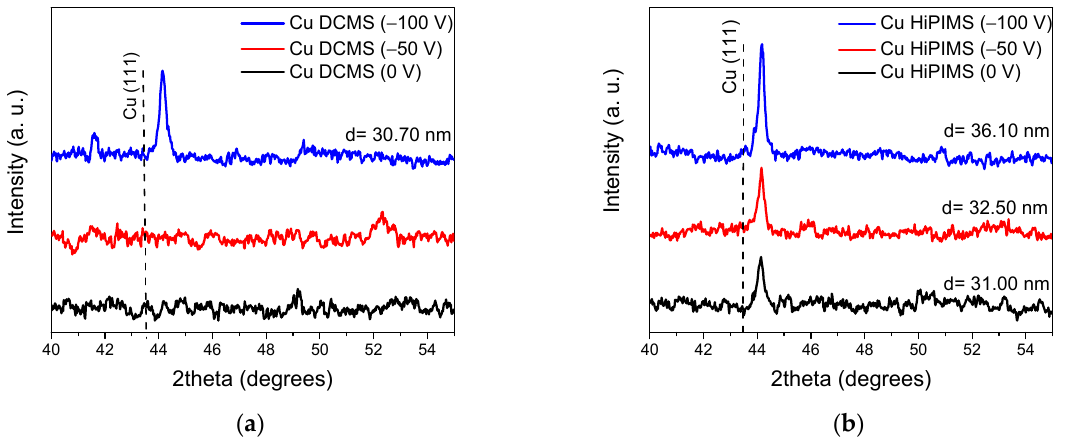
Figure 9. XRD patterns of copper thin films obtained by using DCMS ( a ) and HiPIMS ( b ) techniques at different substrate bias voltages.